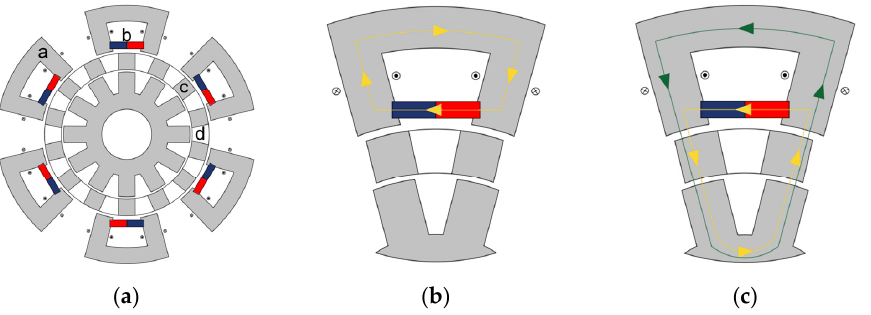
Figure 23. PM assisted DSSRM with segmental outer stator and rotor ( a ) is a simplified model where “a” is the U-shaped segmental stator, “b” depicts PMs, “c” is the segmental rotor, and “d” is the non-magnetic isolator; ( b , c ) are the flux paths without phase winding excited and with phase winding excited, respectively. Table 1. Comparison of advantages, disadvantages, and applications of various SSRMs.